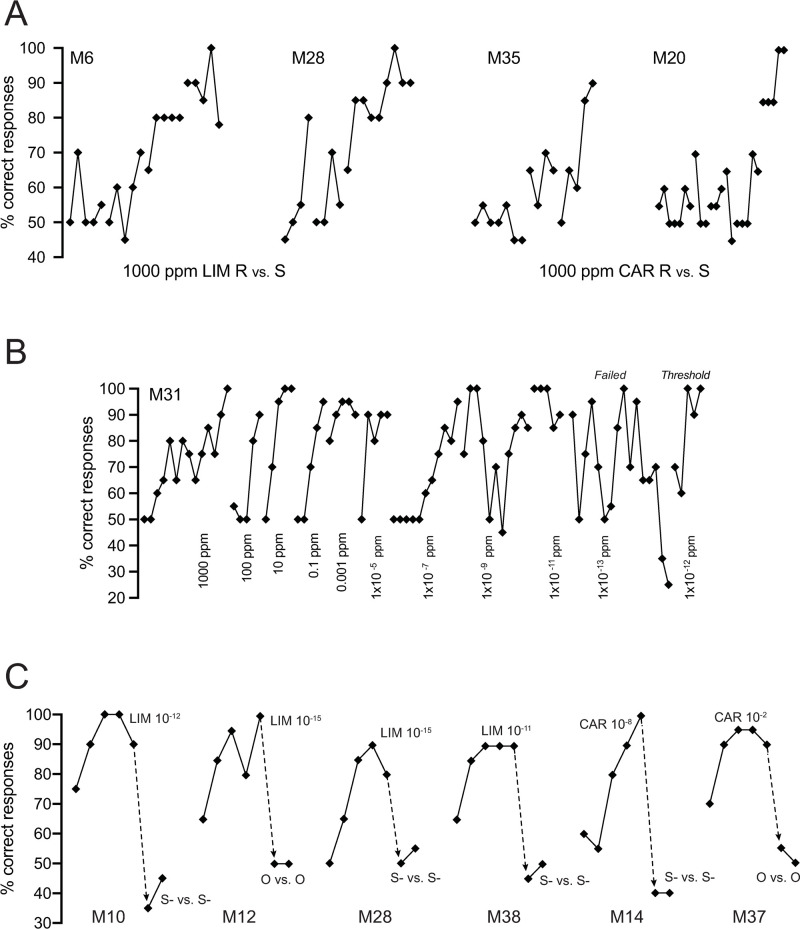
Percent correct responses (diamond symbols) during consecutive blocks of 20 trials.The plot should be read from left (first block) to right (last block). Lines between symbols connect blocks in the same session. A. Initial blocks for four mice, two discriminating 1,000 ppm limonene (LIM) R vs. S, two discriminating 1,000 ppm carvone (CAR) R vs. S. Note that all mice except M20 made progress toward discrimination within a session or two. B. Entire record for Mouse 31 on her path to limonene discrimination threshold. Discrimination took the form S vs. R + S where R and S are the two stereoisomers of limonene at 1,000 ppm stock concentration in mineral oil. The stated concentrations are consecutive dilutions of R stock in S stock (left to right). Note that % correct responses often fell to chance levels when concentration was decreased. As was typical, % correct responses became quite unstable near threshold (see failure at 1 x 10−13 ppm). Note that for first five blocks of concentration 1 x 10−7 the mouse was indiscriminately responding on every trial. C. Examples, in six mice, of control procedure to assure subjects were discriminating on the basis of experimental stimuli. In the case of S- vs. S- the mouse was given identical S- stimulus on every trial. In the case of O vs O, mouse was given identical odorless mineral oil on every trial. Note that highly successful discriminations dropped to near chance levels of correct responding (50%) when the identical stimulus was associated with rewarded and unrewarded trials (dashed arrows).